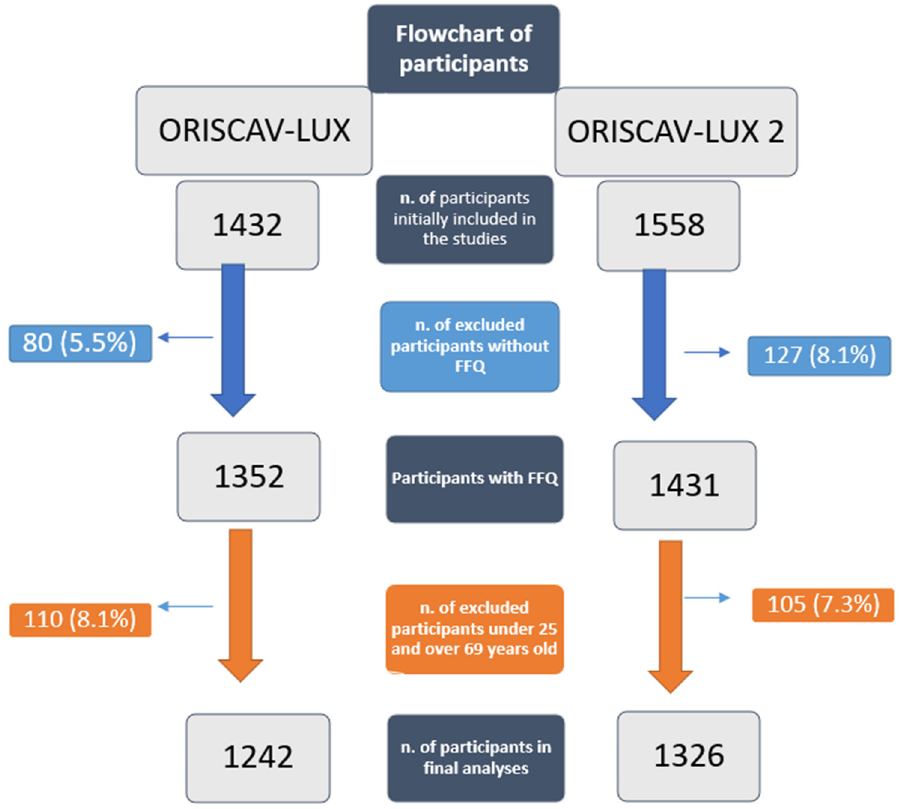
Figure 1. Flowchart of participants in ORISCAV-LUX and ORISCAV-LUX 2. Missing data: For the variable “income”, we grouped the missing data into “did not answer”. Therefore, no other participants were excluded from the analysis due to missing data in sociodemographic variables (Table 1). The replacement of missing data by the means or their imputation was not considered as a suitable strategy as data were not to be missing at